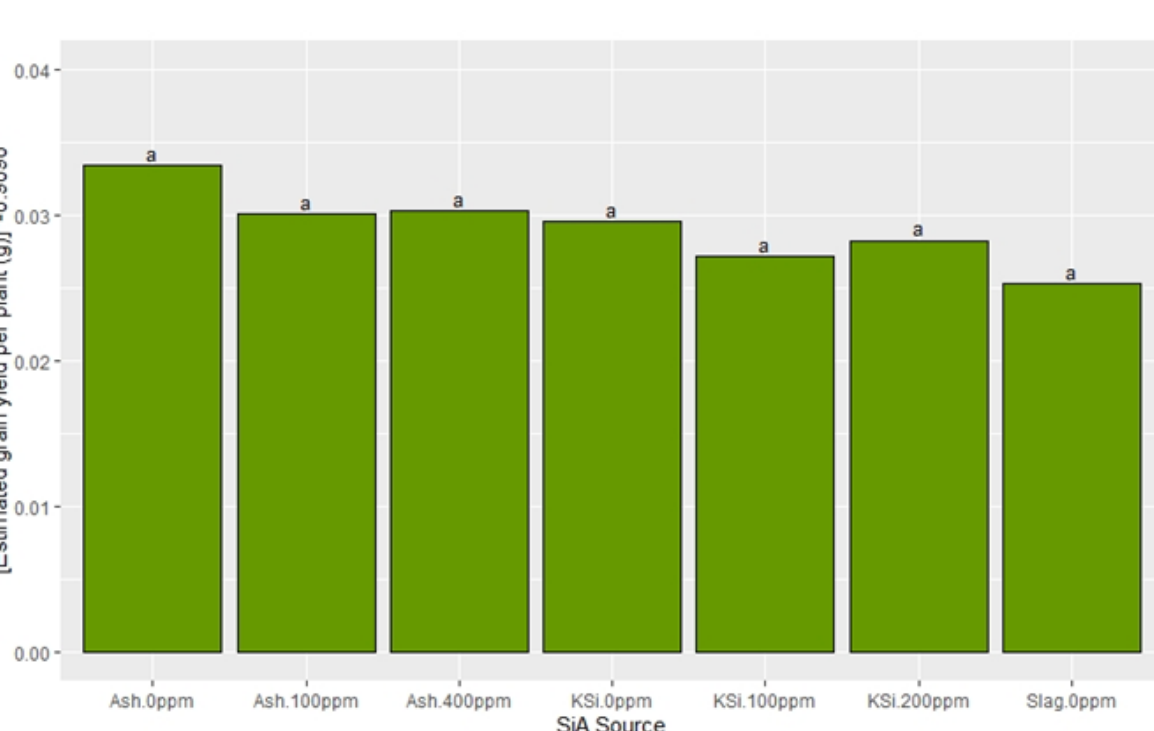
Figure 12 . Statistical summary of [ Estimated grain yield per plant test, α = 0.05. Ash stands for rice husk ash; KSi, for potassium silicate and Slag, for ladle furnace slag.